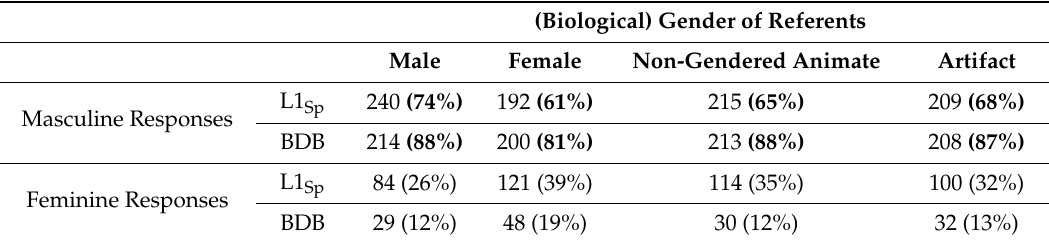
Table 4. Distribution of participants’ responses, by referent.